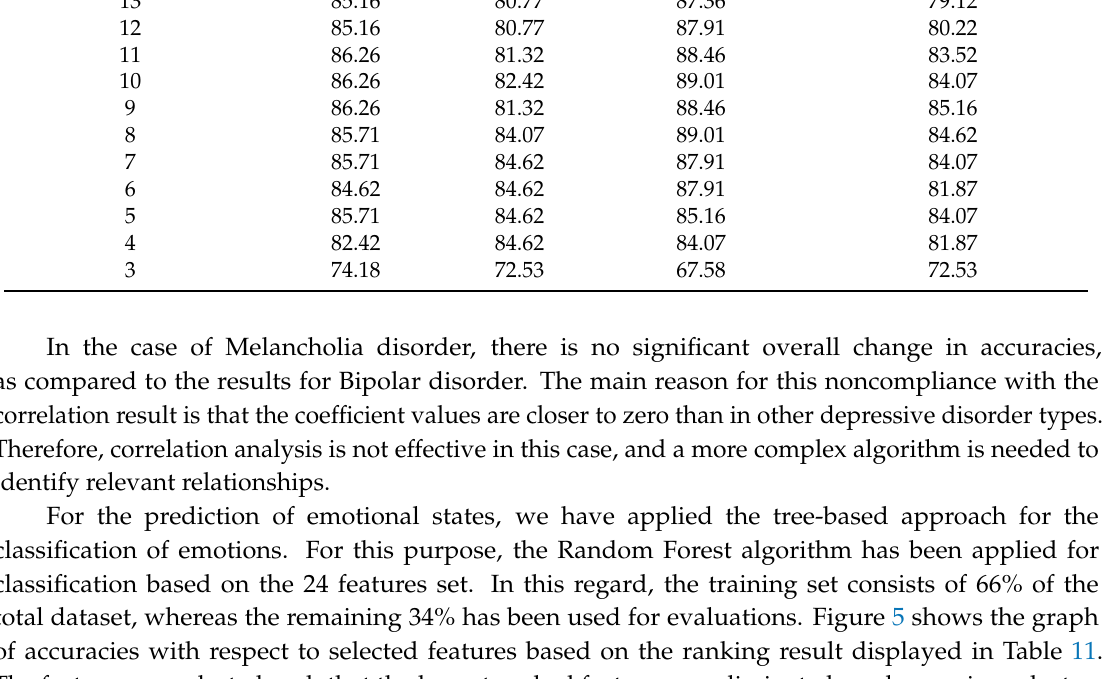
Table 12. Classification Results for Bipolar Disorder. SVM is abbreviation for Support Vector Machines. Number of